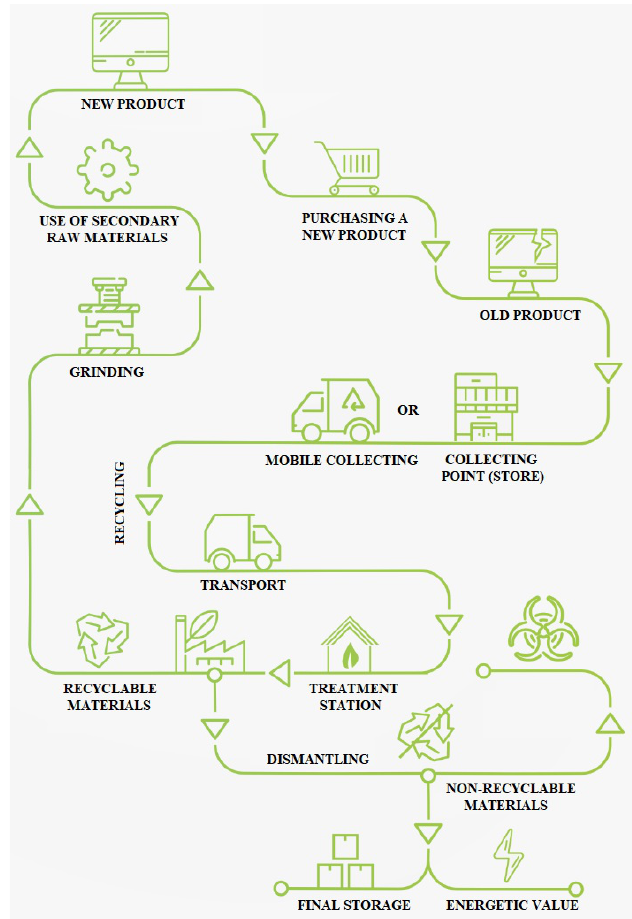
Figure 4. Life cycle of EEE (adapted from [136]).